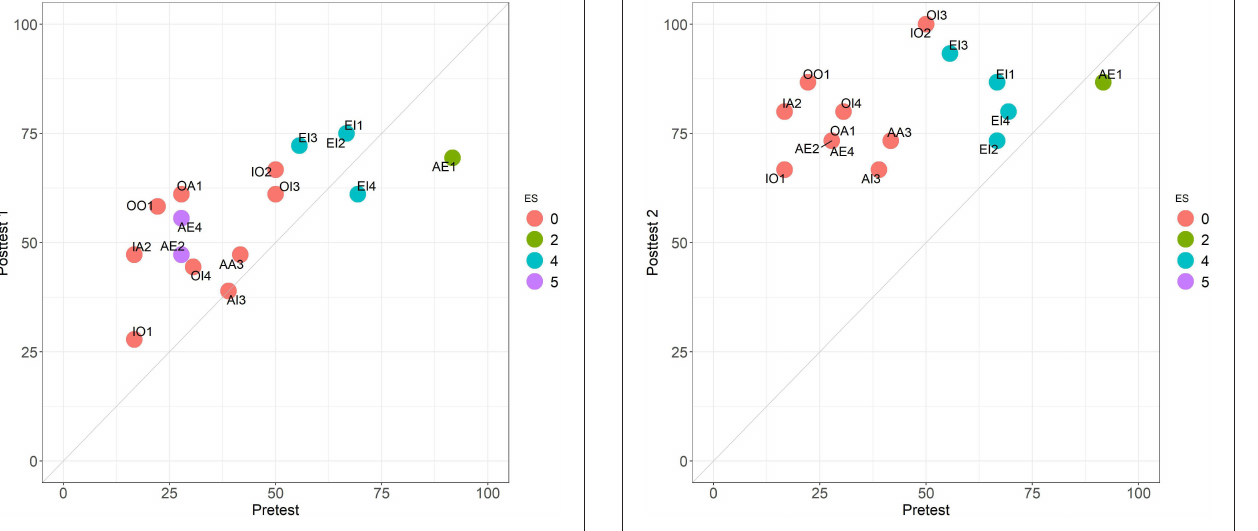
FIGURE 9 | Comparison between the pretest (EV task) and posttest 1 (CMA2 task) in Experiment 2. Performance across the 16 problems of set 1. Colors follow the ES classification.